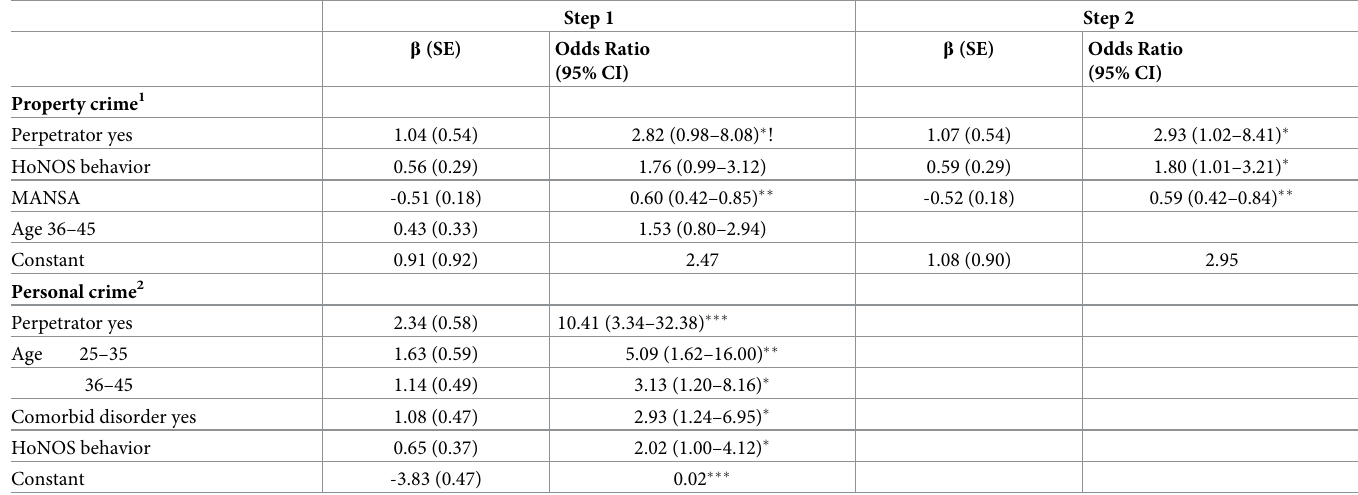
Table 5. Multivariate analyses of factors associated with property crime and personal